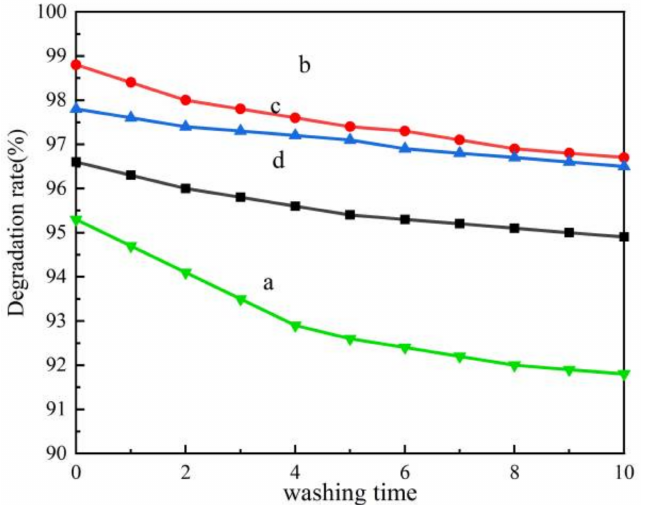
Figure 10. Degradation rates of methylene blue in ZnO/cotton ( a ), OA-ZnO/cotton ( b ), TA- ZnO/cotton ( c ) and SA-ZnO/cotton ( d ) at different washing